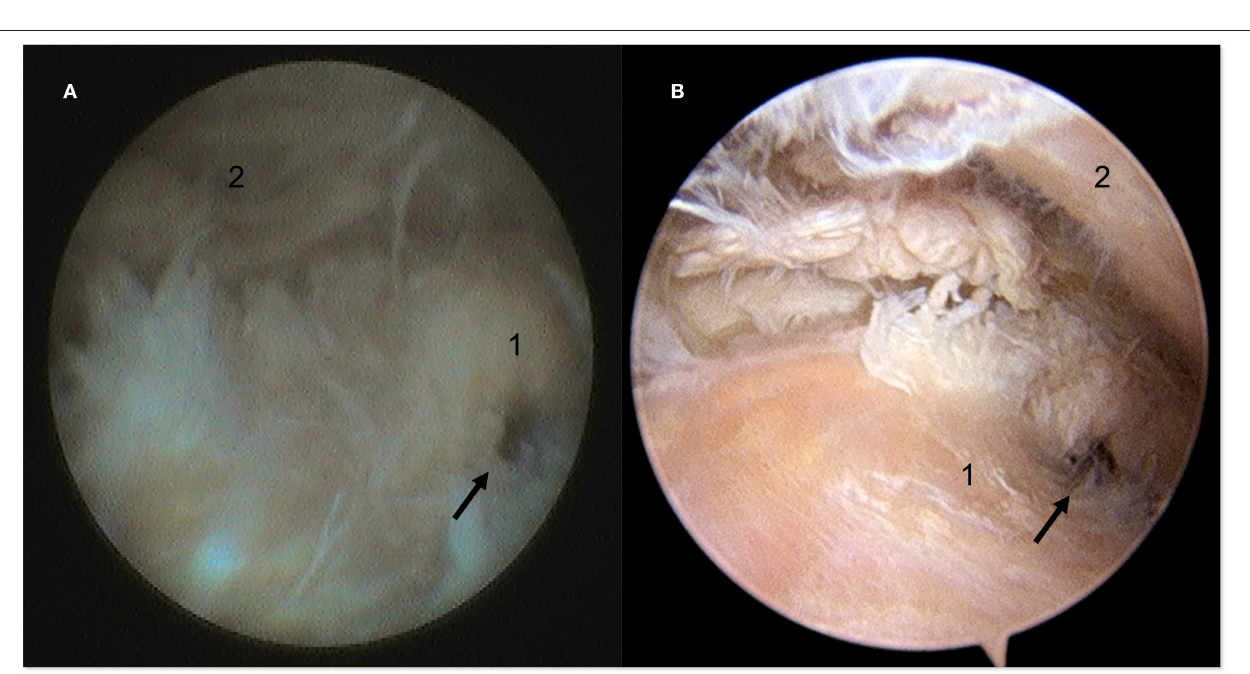
FIGURE 3 | Still arthroscopic image showing the caudal aspect of the condylar process of the mandible (1) with synovial plical insertion (2) within the discomandibular joint (DMJ) using the NAS (A) and STAN (B) .